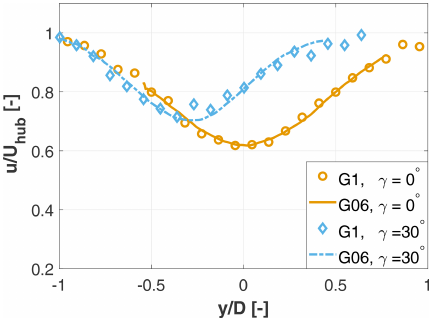
Figure 15. Velocity deficit for the G06 and G1 turbines 5D down- stream of the rotor, for both a wind-aligned and a high misalign- ment angle of γ = 30 ◦ . Measurements were taken at similar thrust coefficients ( C T = 0 . 72 for G06 and C T = 0 . 75 for G1) in similar turbulent inflows in different wind